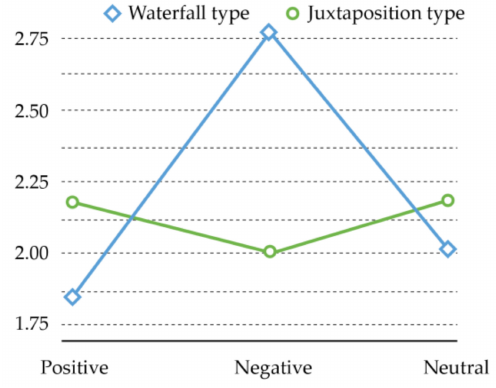
Figure 7. The interaction diagram regarding interface